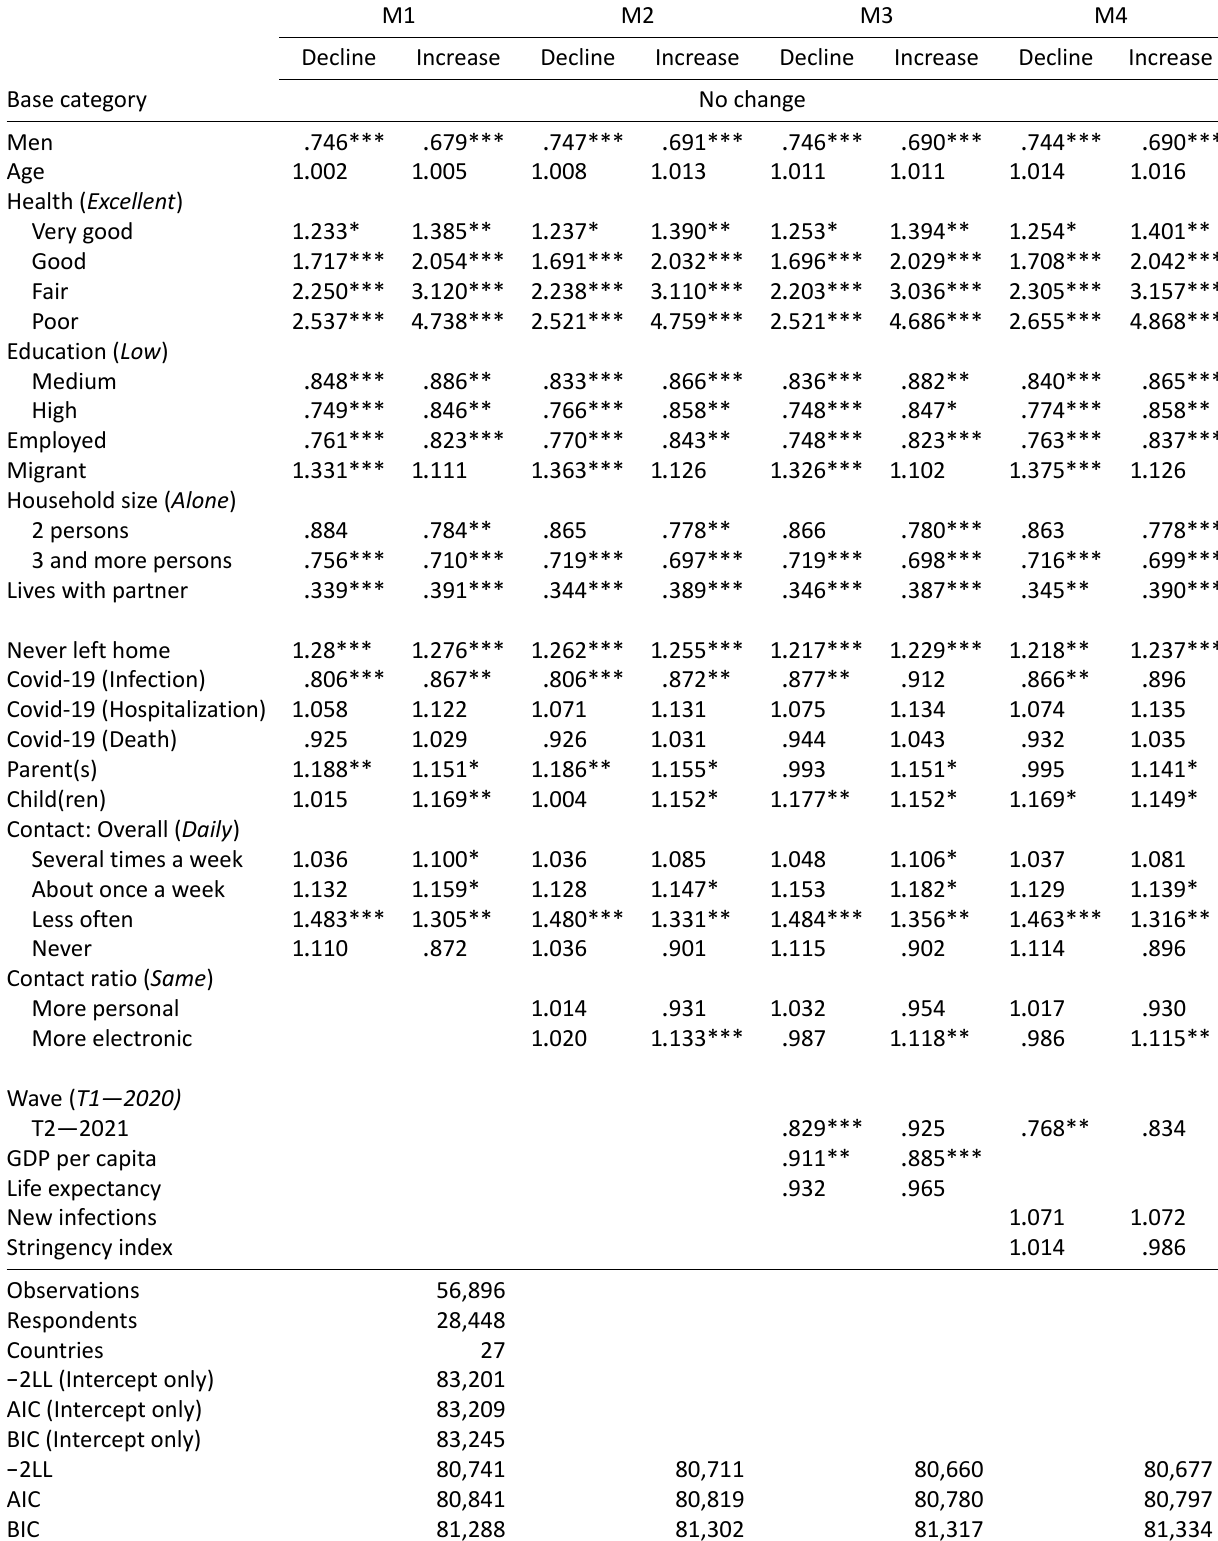
Table 2. Patterns of changed loneliness since the outbreak of